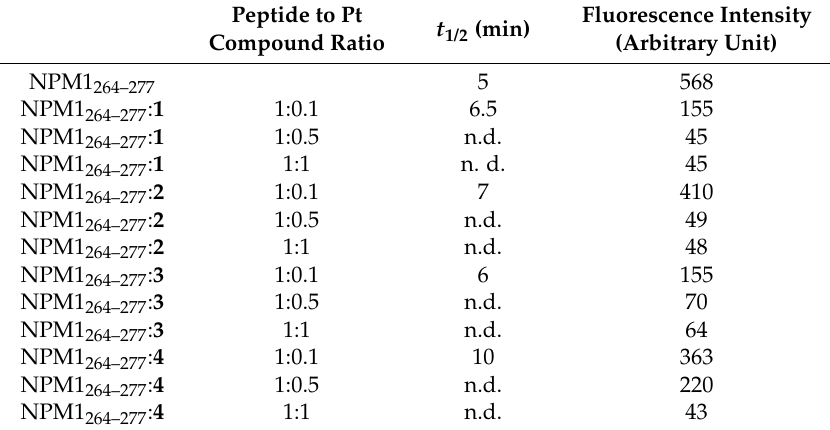
Table 2. Aggregation kinetics ( t 1 ) and maximum fluorescence intensities of NPM1 264–277 following 2 ThT emission at indicated peptide:Pt compounds molar